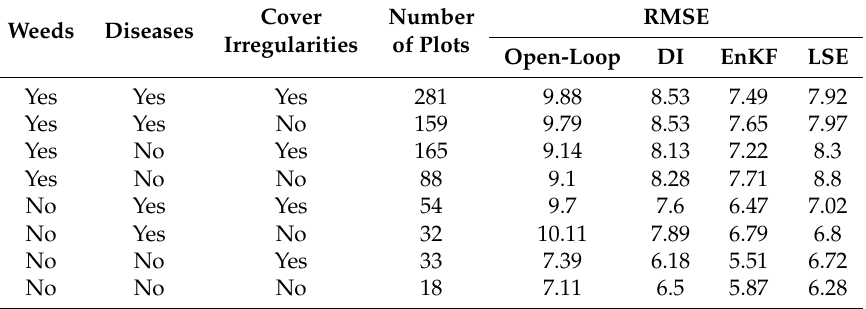
Table 6. Forecasting error (RMSE) for assimilation methods as a function of limiting factors diagnosed on fields. The three columns ‘weeds, ‘diseases’ and ‘cover irregularities’ identify the different types of yield limiting factors observed. If the value ‘Yes’ is given, the fields tagged with the limiting factor associated were included in the analysis. Cover Number Weeds Diseases Irregularities of